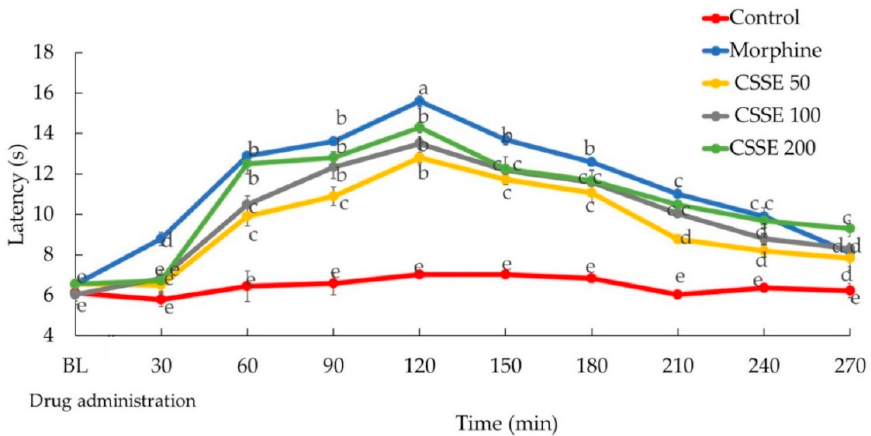
Figure 3. Effect of a single administration of CSSE (50, 100, or 200 mg/kg) on the latency time of mice to react to heat in the hot plate test. Morphine (1 mg/kg, i.p) is used as positive control. Each value represents the mean ± SEM ( n = 6); different letters indicate a significant difference during the duration of the experiment or between treatments ( p < 0.05) (ANOVA II Duncan’s test).